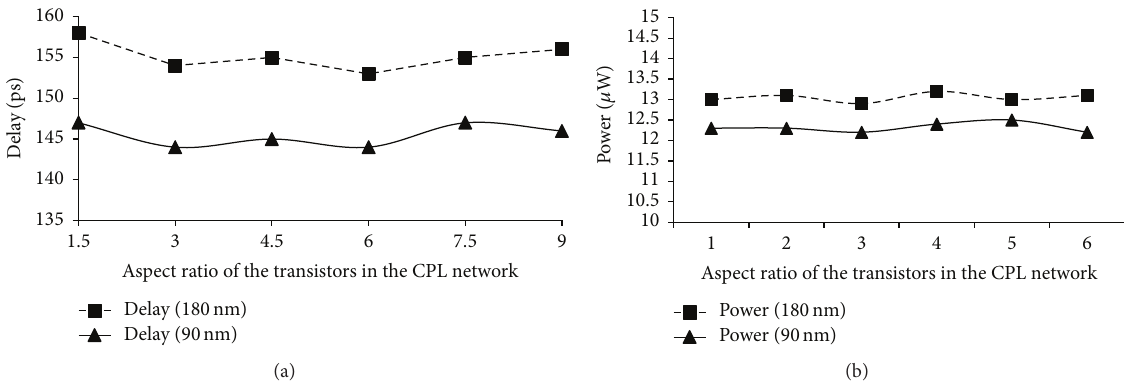
Figure 9: Performance of the two-input H-DyCML XOR gate by varying the aspect ratio of the transistors in the PDN: (a) delay results; (b) power results.